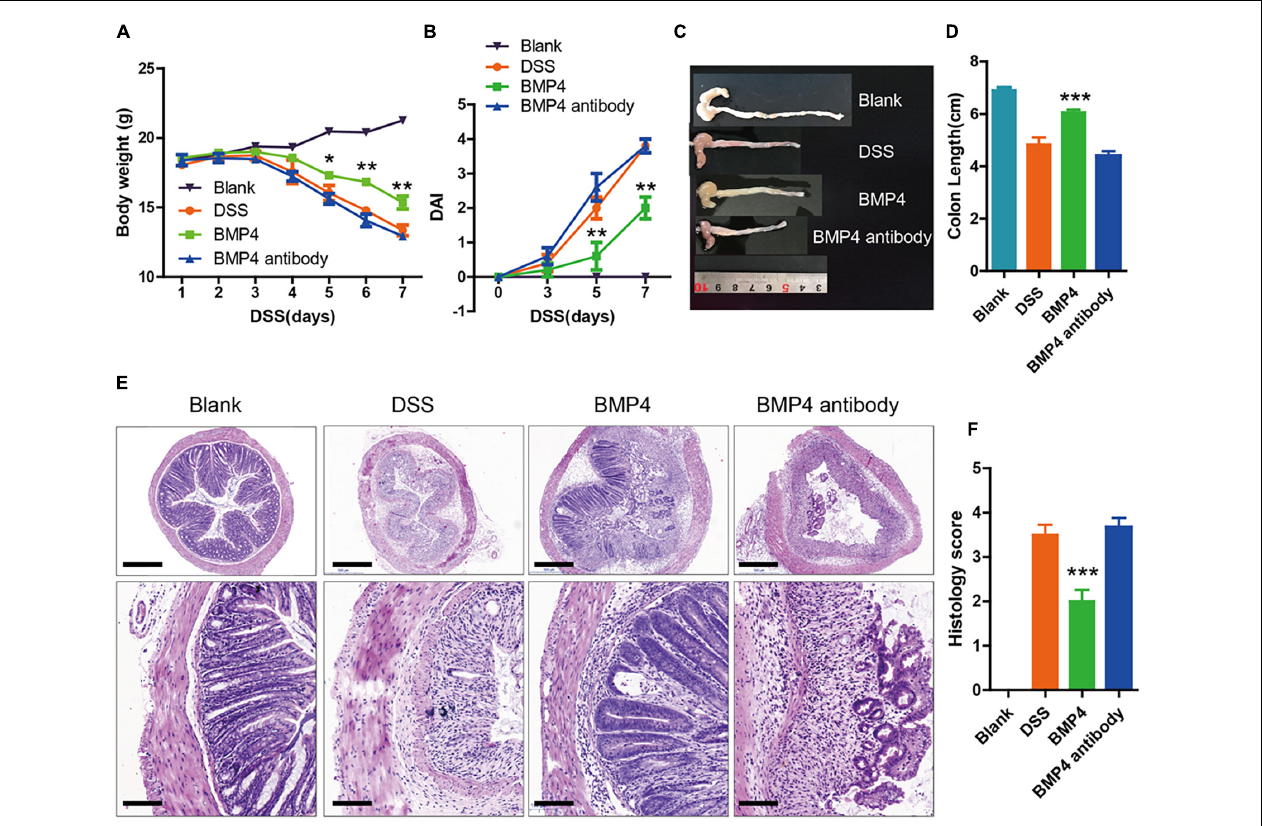
FIGURE 4 | BMP4 alleviates DSS-induced colitis. (A,B) Body weight and DAI score of mice treated with DSS. At day 3, the control group was administered with saline, the BMP4 group was administered with BMP4, and the BMP4 antibody group was administrated with anti-BMP4 antibody. (C,D) Colon length from different groups. (E) Sections of colon tissues stained with H&E and (F) histology scores from different groups. n = 10 (control), n = 10 (BMP4), n = 10 (anti-BMP4). Data represent mean ± SD with three independent experiments. One-way ANOVA and Bonferroni tests for multiple testing were applied in all cases. * p < 0.05, ** p < 0.01, *** p < 0.001. Scale bar = 500 and 100 µ